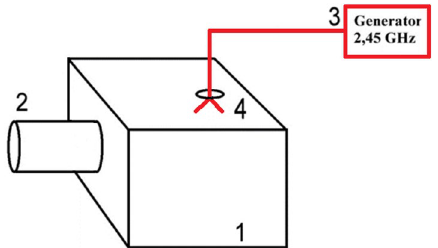
Figure 1. Design of the apparatus for rewarming limb frostbites. (1) A chamber. (2) A soft radioprotective sleeve. (3) A microwave generator. (4) An antenna.